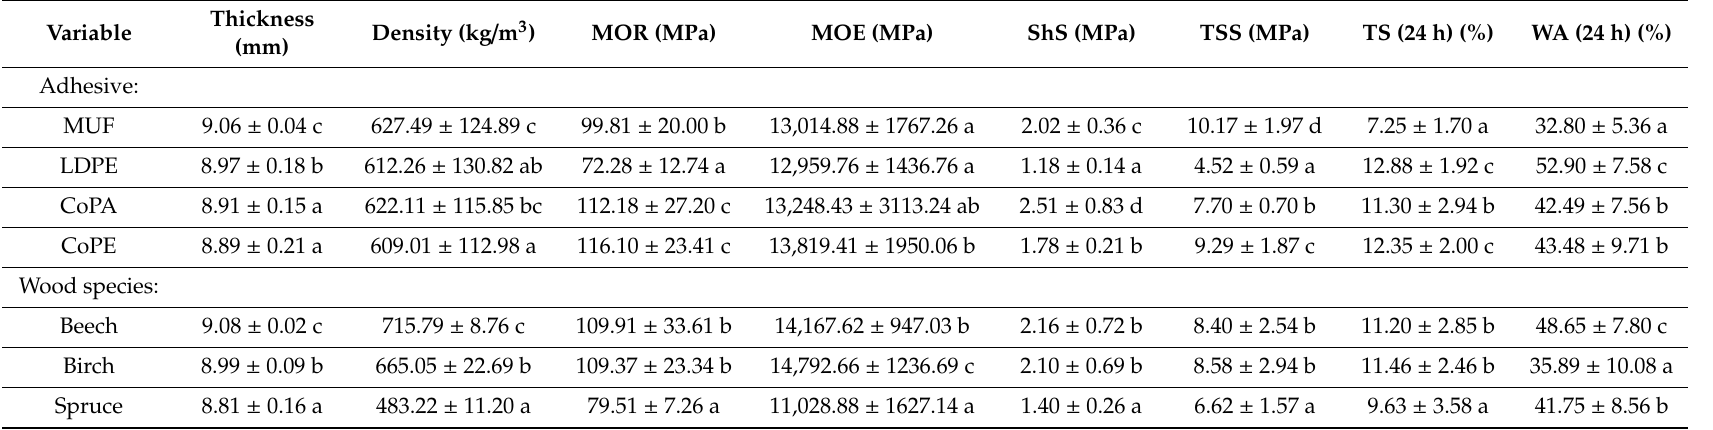
Table A3. Duncan’s test results for selected physical and mechanical properties of plywood panels.